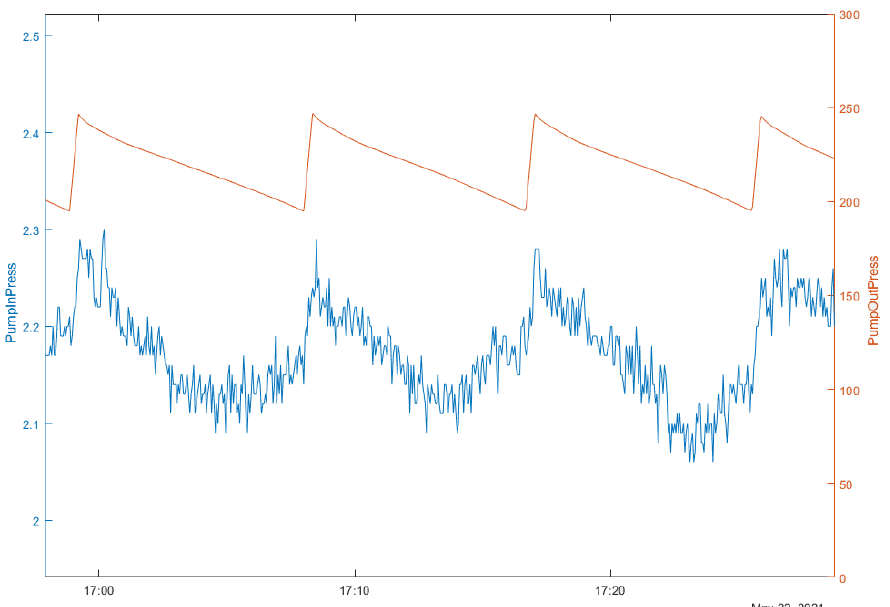
Figure 13. Pump inlet pressure (mbar) and pump outlet pressure (mbar), as measured in the pilot